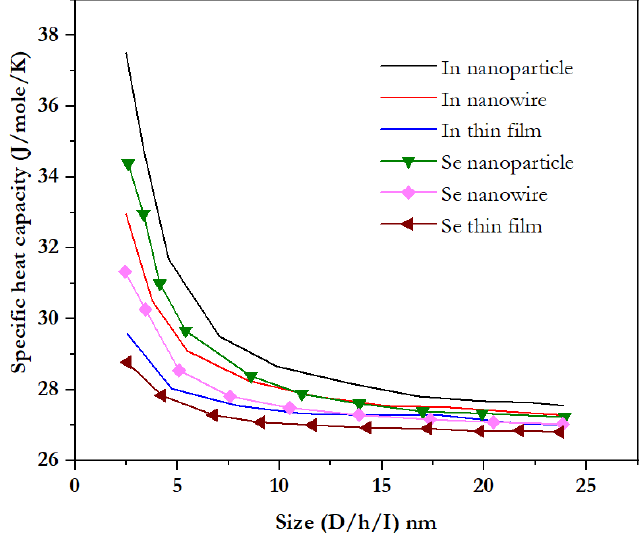
Figure 6. Shape dependent specific heat capacity for In and Se [32] .